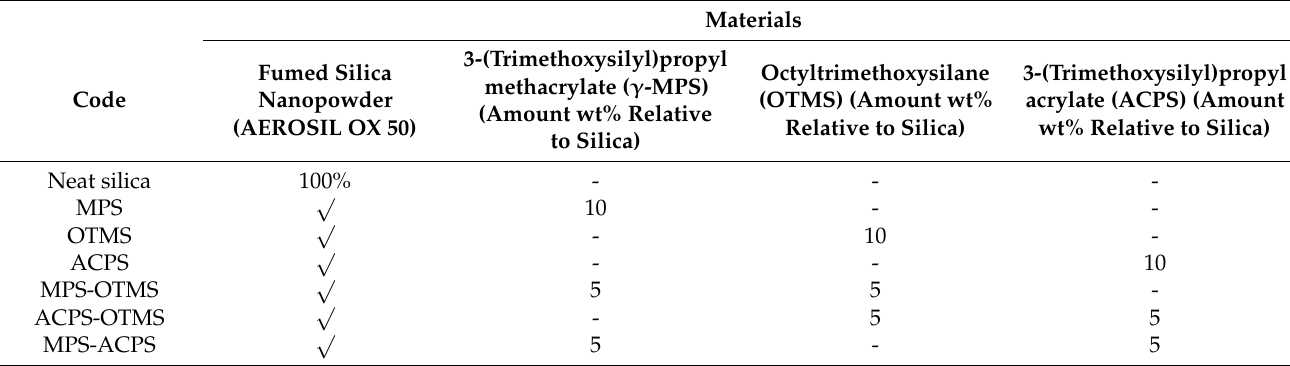
Table 1. Materials used to prepare each